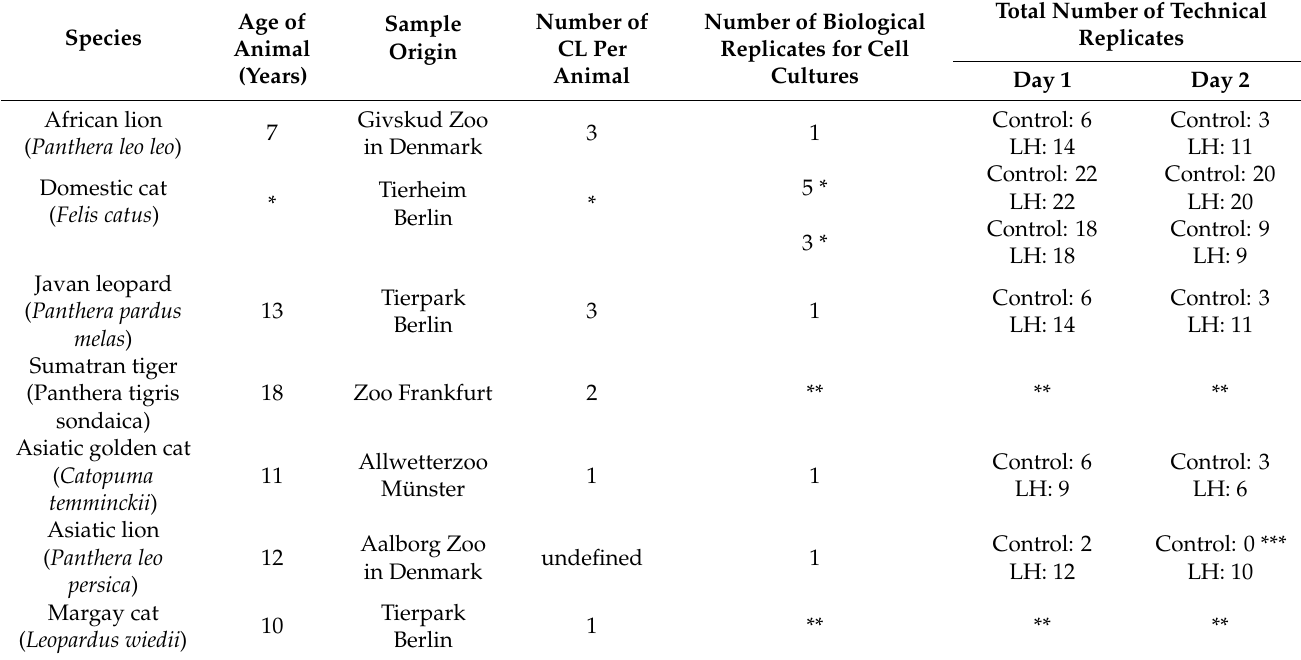
Table 1. Detailed information about samples from felid species and replicate